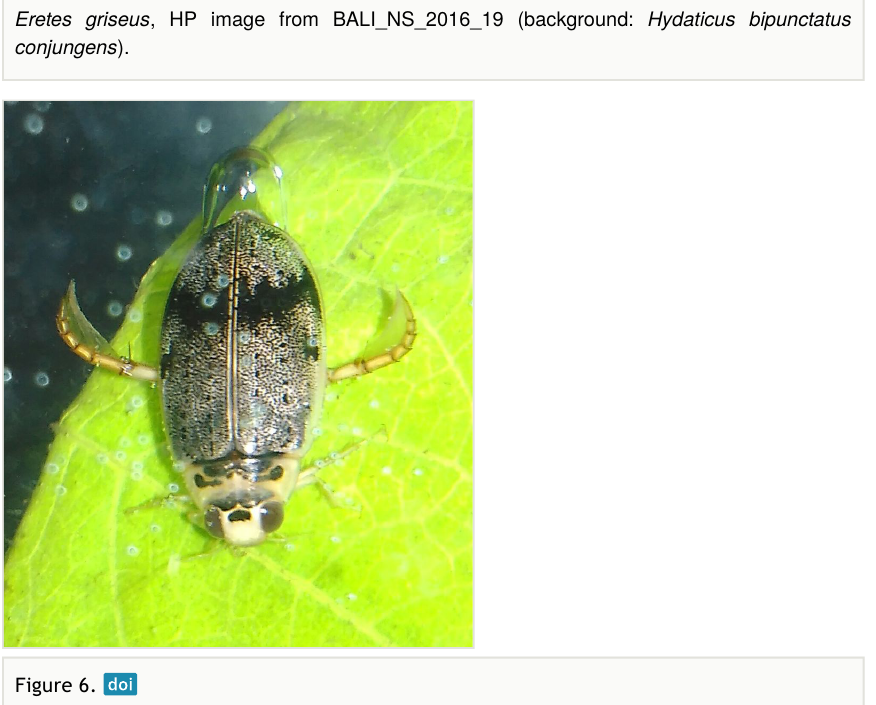
Figure 6. Eretes griseus , HP image from